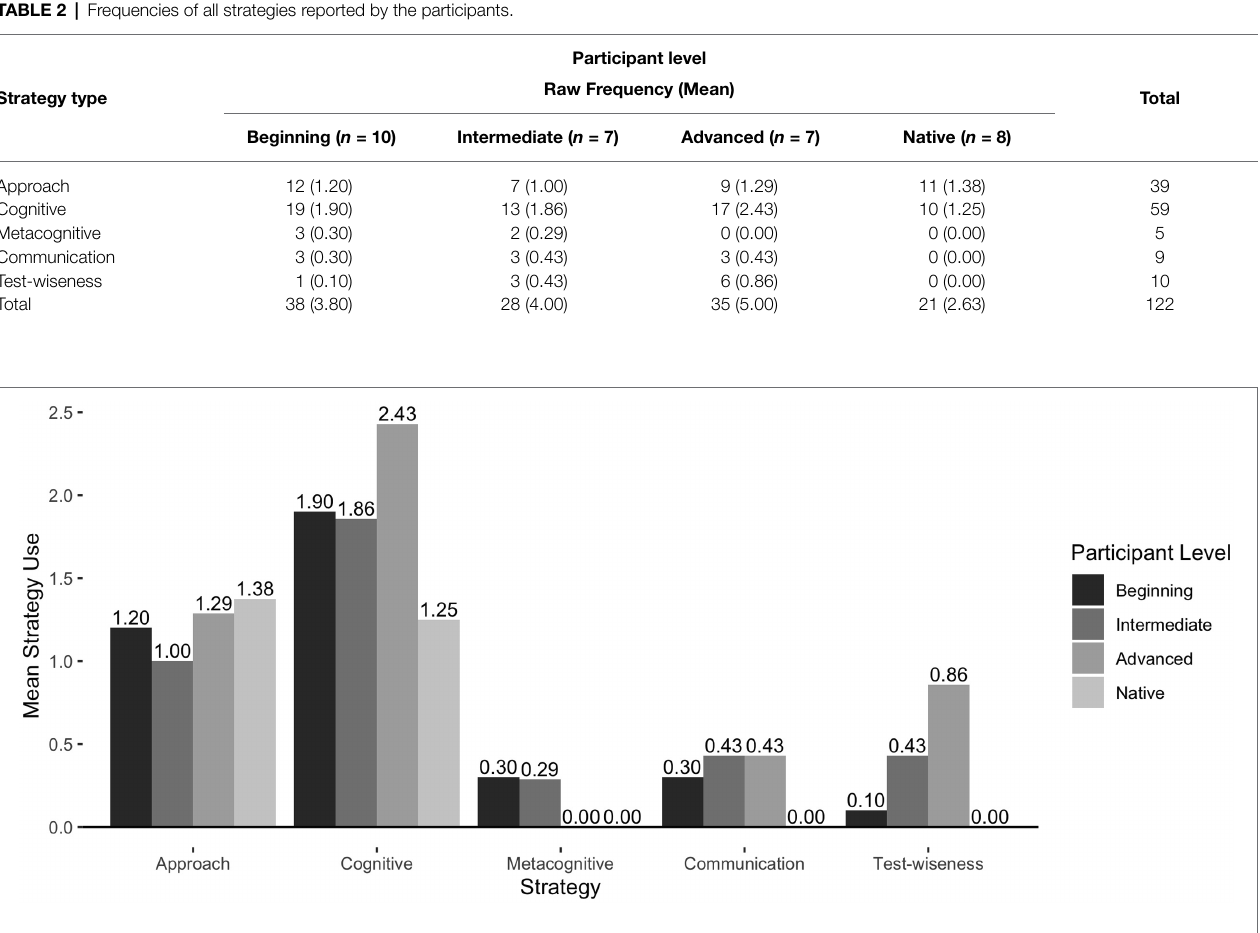
TABLE 2 | Frequencies of all strategies reported by the participants.